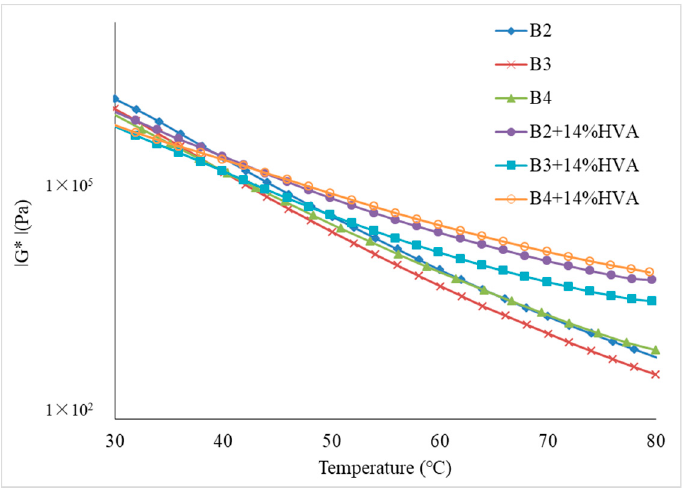
Table 3. Test results of high temperature performance grade.